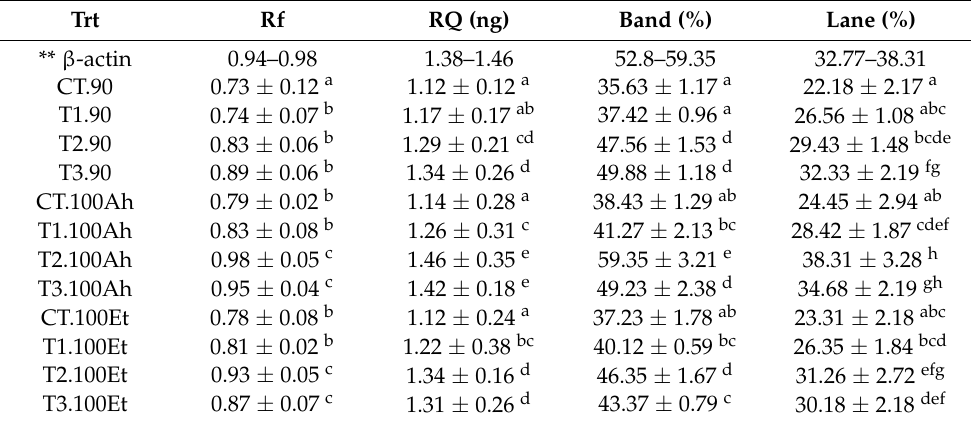
Table 2. Showing densitometry parameters of the Mx gene.